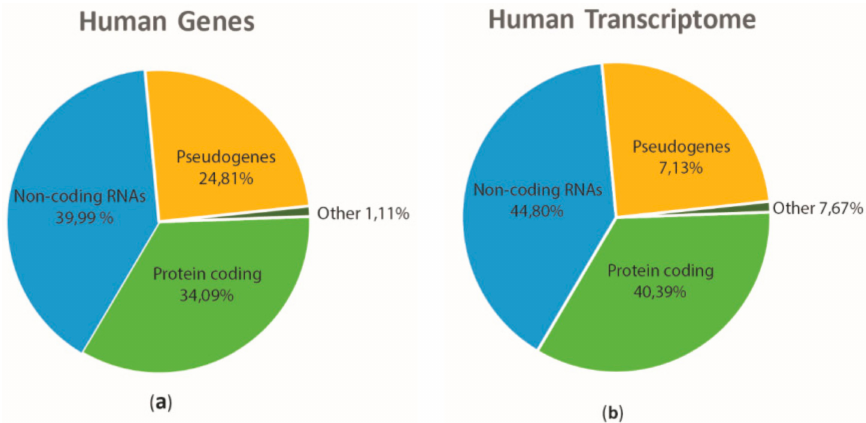
Figure 1. Overview of functional elements of the human genome and of the associated transcriptome. Pie chart showing the percentage of human genes ( a ) and transcripts ( b ) based on the current Release (Release 28, GRCh38.p12) of GENCODE. Classification is referred to Gene/Transcript Biotypes in GENCODE & Ensembl and to VEGA descriptions (available online: http://vega.archive.ensembl.org/ info/about/gene_and_transcript_types.html). The non-coding transcriptome includes both small and long non-coding RNAs; pseudogenes incorporate processed, unprocessed, transcribed, translated, polymorphic and unitary sequences; other includes IG/TCR and their pseudogenes, together with non-stop decay and non-sense mediated decay.